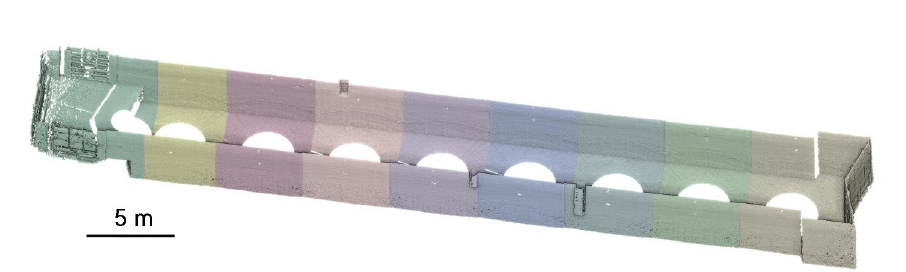
Figure 13. Complete 3D sonar model of the lock. The nine scans are represented with different